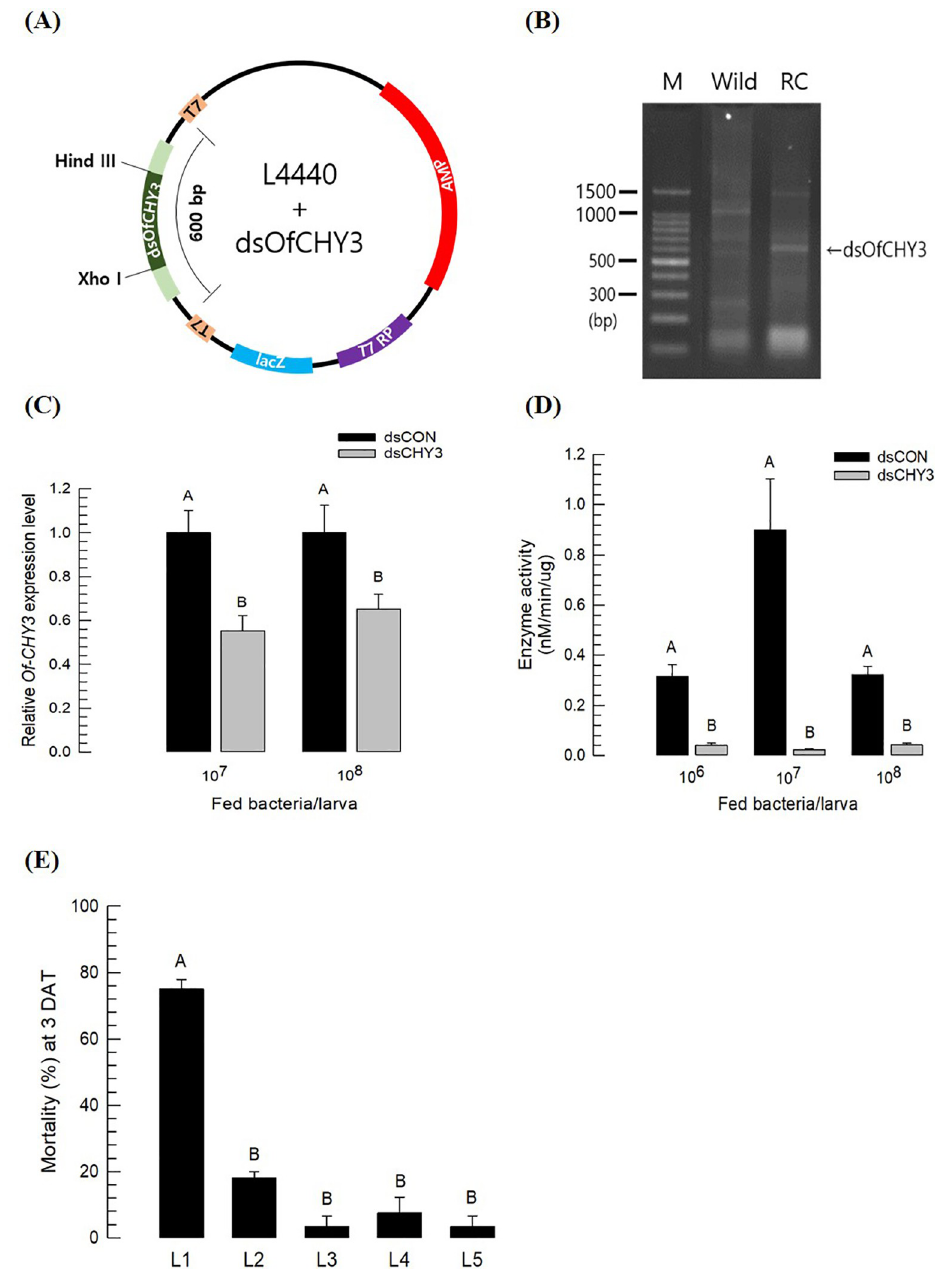
Fig 8. Influence of recombinant E . coli expressing dsRNA specific to Of-CHY3 (‘dsOfCHY3’). (A) Cloning map of recombinant vector (L4440-dsOfCHY3). (B) Expression of dsOfCHY3 by bacteria. ‘Wild’ and ‘RC’ represent non- recombinant (L4440) and recombinant (L4440-dsOfCHY3) HT115 bacteria, respectively. ‘M’ represents DNA size marker. (C) Suppression in expression level of Of-CHY3 after recombinant bacterial feeding. (D) Suppression of chymotrypsin activity in the gut juice of O . furnacalis larvae fed with recombinant bacteria. Each treatment was replicated three times. For each treatment, three L4 larvae were used to extract total RNA and collect gut juice. (E) Mortality of O . furnacalis larvae at different larval stages. All treatments were used for oral administration of the recombinant bacteria by loading 10 8 cells to the artificial diet. Mortality was determined at 3 days after treatment (‘3 DAT’). Each treatment was replicated three times. For each replication, ten larvae were used. Developmental alteration after bacterial feeding was determined. Different letters above standard error bars indicate significant difference among means at Type I error = 0.05 (Tukey